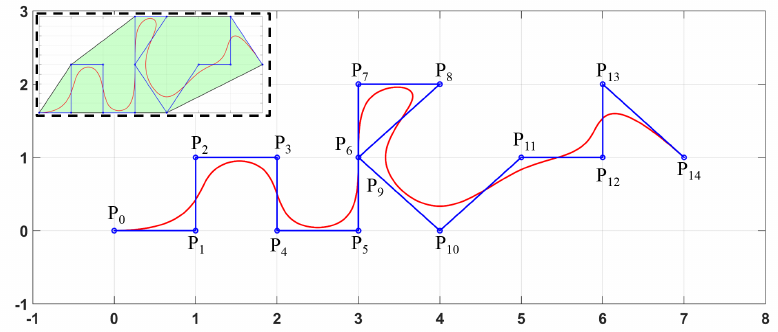
Figure 16. Example of a cubic B-Spline curve consisting of 15 control